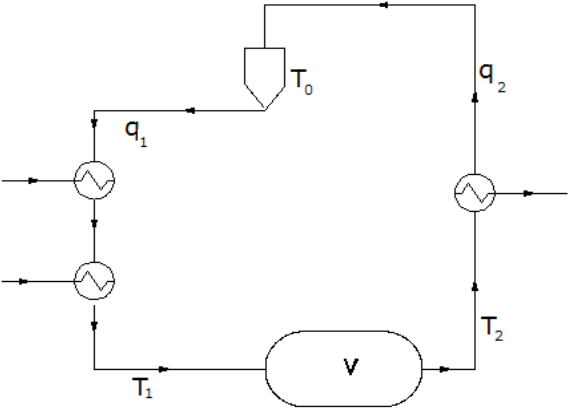
Figure 9. Conceptual scheme of a district heating network with an intermediate